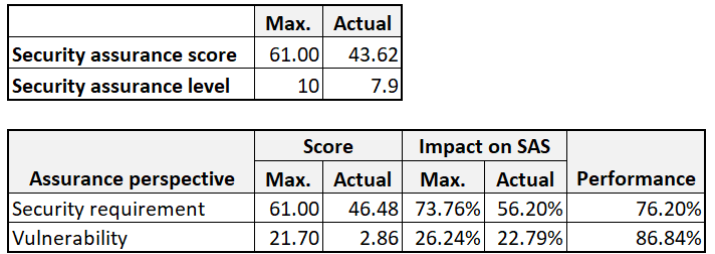
Figure 3. Security assurance scoreboard—top level.